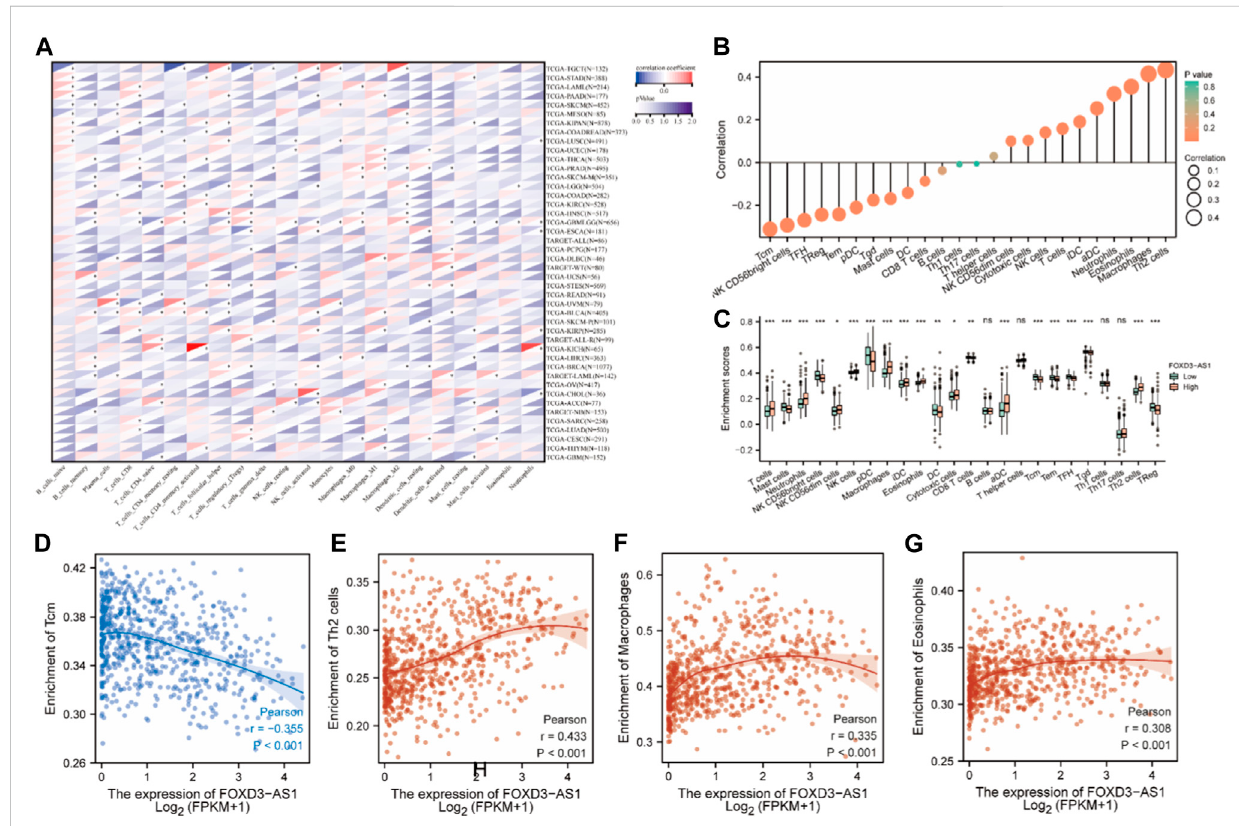
FIGURE 13 Abundance analysis of immune checkpoints and immune cell in fi ltration. (A) Heat map of FOXD3-AS1 correlation with 22 different immune cell types in pan-cancer; (B) The lollipop chart showing different degrees of correlation between FOXD3-AS1 and immune cells; (C) Boxplots of immune cell in fi ltration differences between high and low FOXD3-AS1 expression groups; (D – G) Scatter plots of correlation analysis between FOXD3-AS1 expression and Enrichment of Tcm (D) , and nrichment of Th2 cells (E) , respectively. Enrichment of Macrophage (F) , Enrichment of Eosinophils (G)